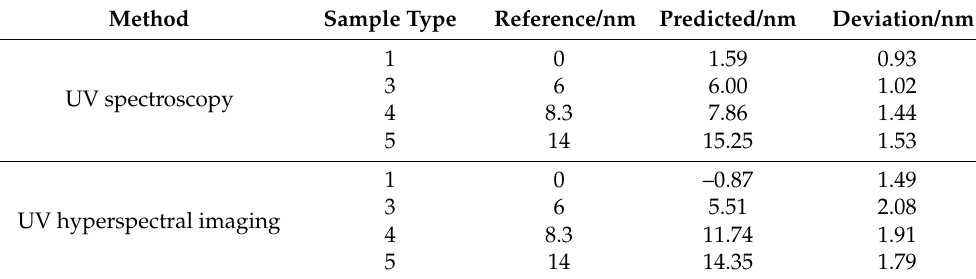
Table 3. Prediction of the oxide layer thicknesses for direct bonded copper from PLS-R